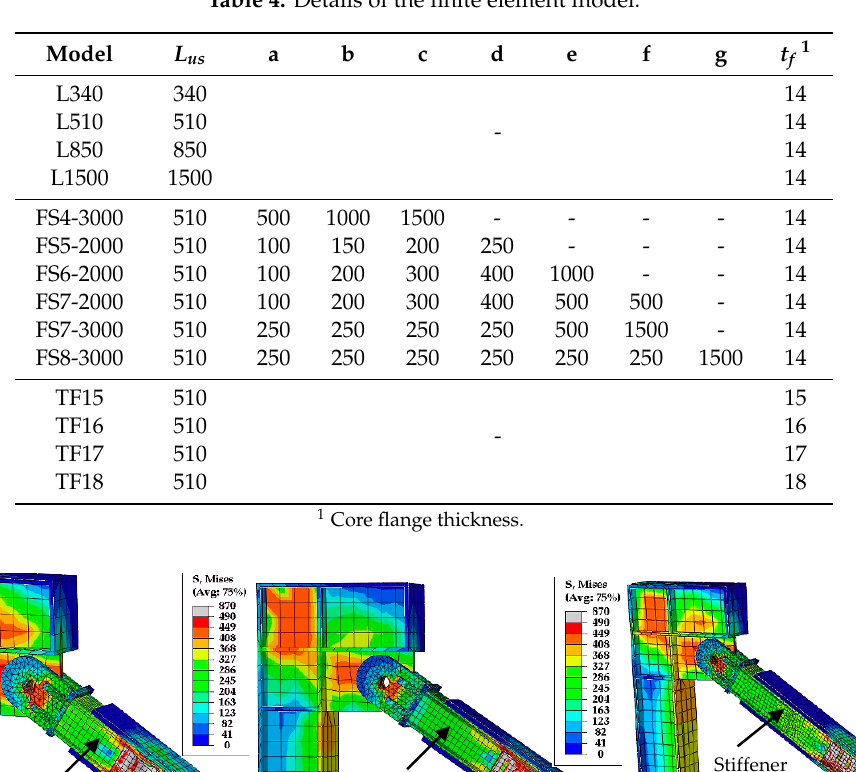
Figure 12. Variables of the parametric study. Table 4. Details of the finite element model.